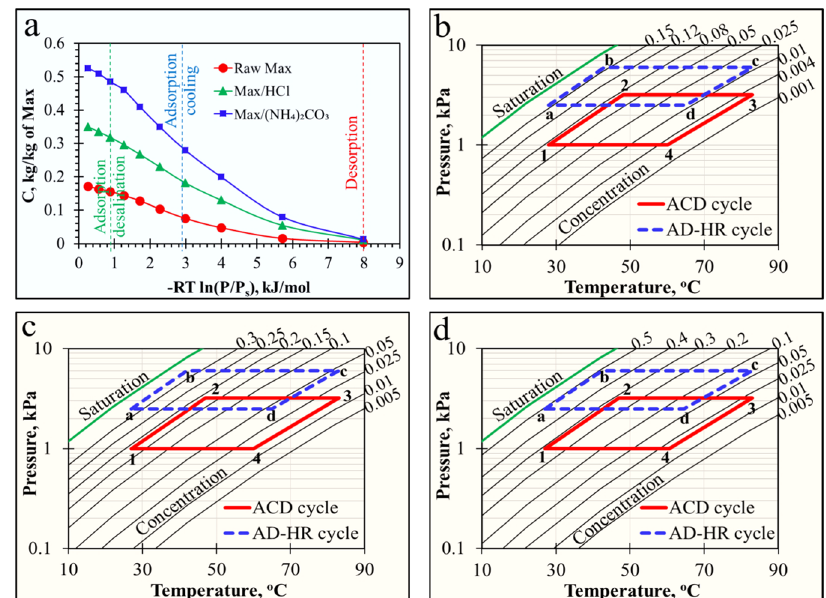
Fig. 4 Adsorption characteristic curves of water vapor on Max samples. a Gibbs energy change ( – RT ln(P/P s )) relationship, b raw Max P-T-C diagram, c Max/HCl P-T-C diagram, and d Max/(NH 4 ) 2 CO 3 P-T-C diagram. The AD-HR cycles have double the water vapor Ad-C of the ACD cycle.